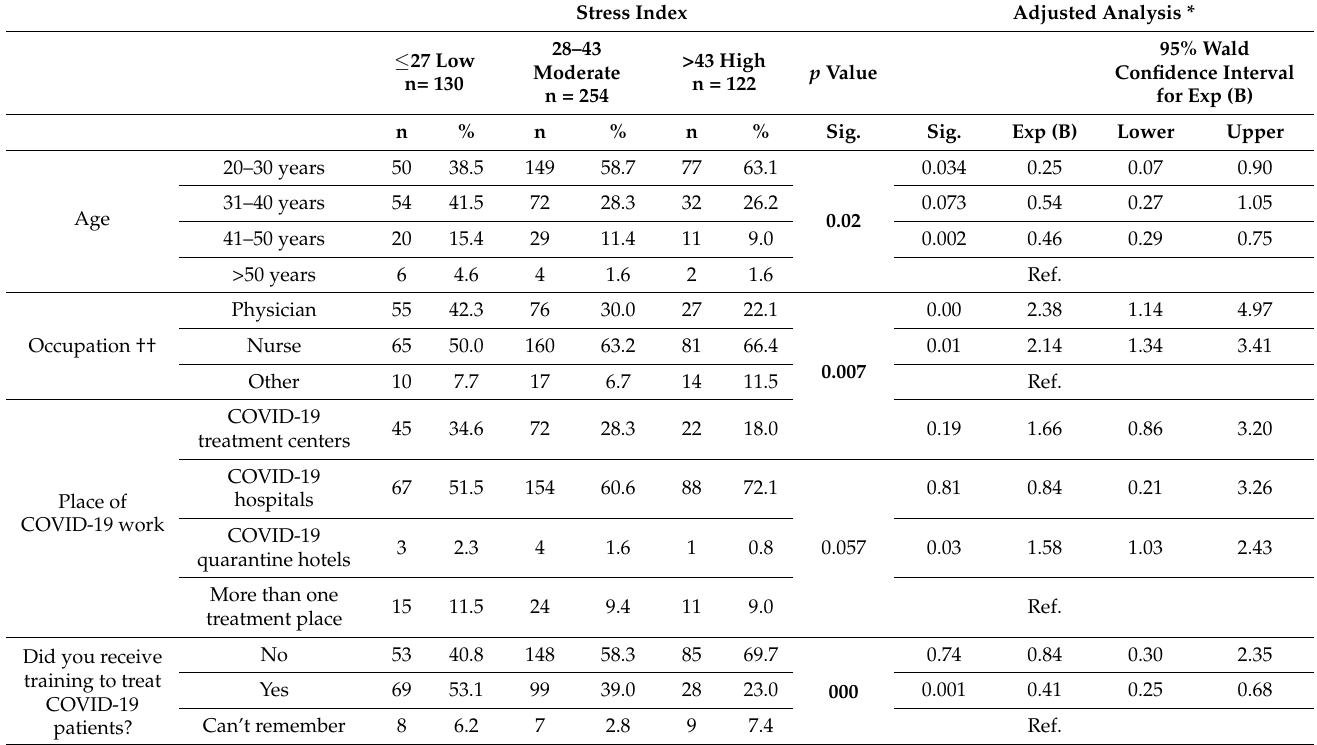
Table 2. Associations between respondents’ characteristics, experiences, and stress scoring index during COVID-19